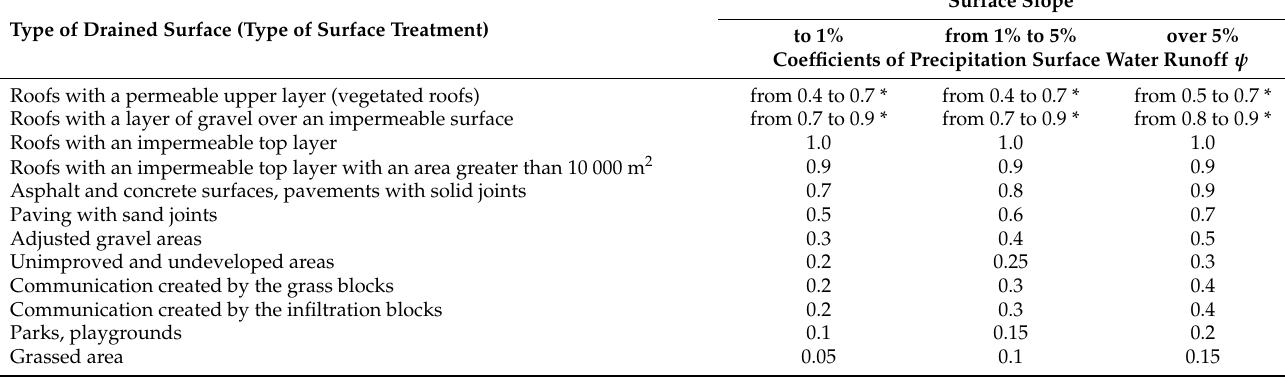
Table 1. Coefficients of precipitation surface water runoff ψ (source: authors according to technical standard Rainwater absorption